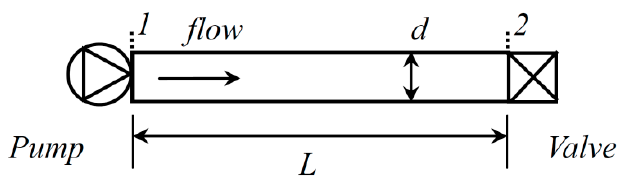
Figure 1. The diagram of the pump–pipe–valve system.